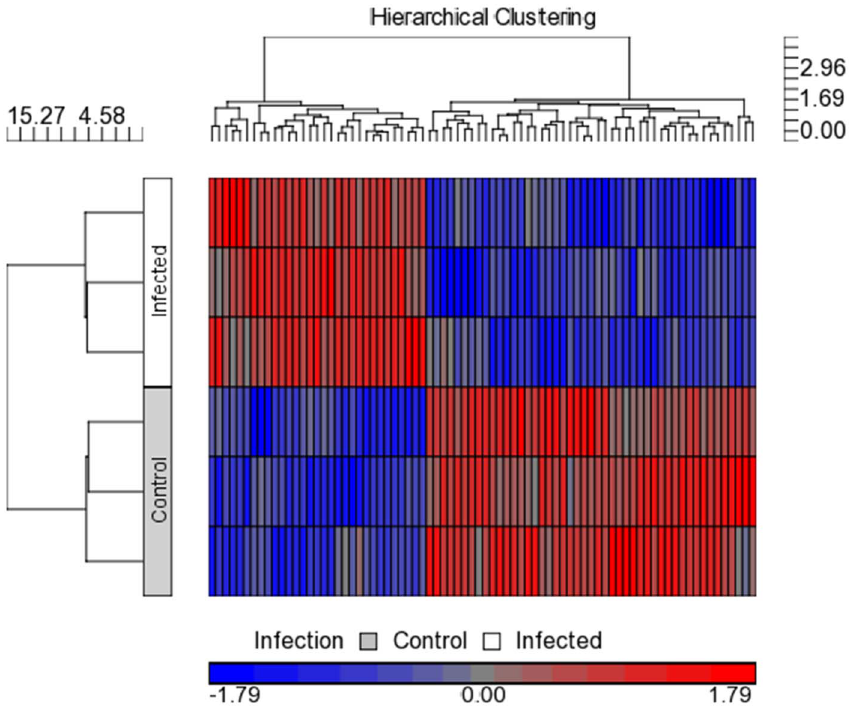
Figure 4. Heat map of the microarray miRNA expression profile of EV71 infected and non-infected control colorectal cells, HT29. The two-way hierarchical cluster heat map showed differential expressed miRNAs of two groups of samples. The miRNAs were chosen according to the cut off p , 0.05 where blue represents miRNAs with decreased expression and red represent miRNAs with increased expression. (n=3, *=p values of , 0.05).